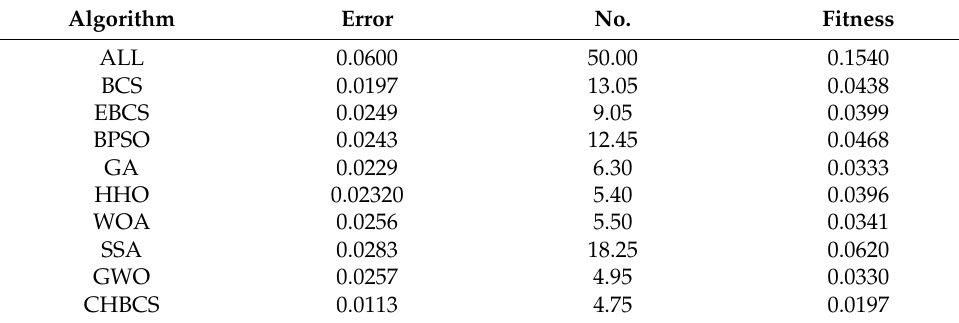
Table 6. Classification results of the CHBCS algorithm and other algorithms.